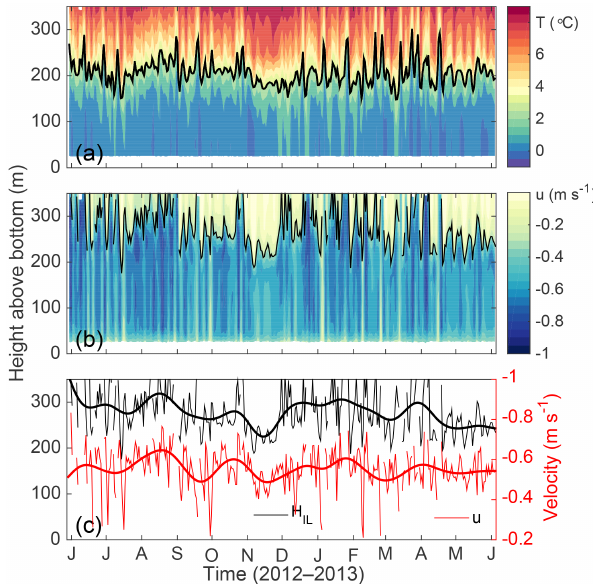
Figure 5. Time–height plots of daily (a) temperature ( ◦ C) and (b) u velocity (ms − 1 ) from mooring C2. The bold black line in (a) marks the 3 ◦ C isotherm, and the thin black line in (b) is the kinematic interface height H IL . (c) Time series of daily (thin) and 3-week low- passed (bold) H IL (black) and the plume velocity (red) averaged within H IL .